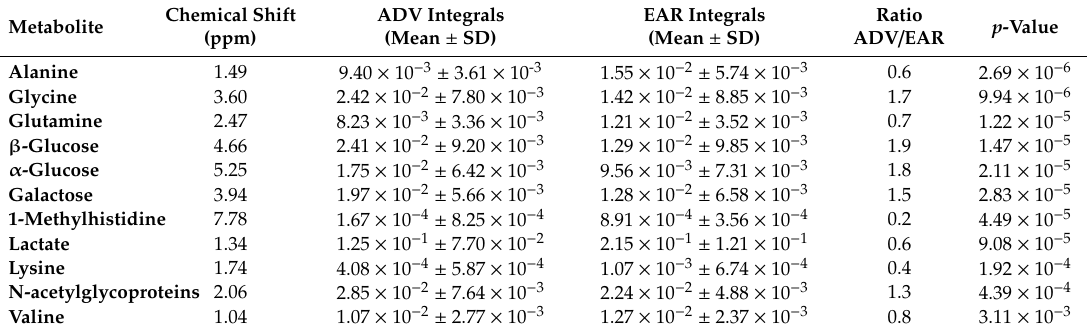
Table 2. Quantitative comparison of serum metabolites from ADV and EAR HCC patients.